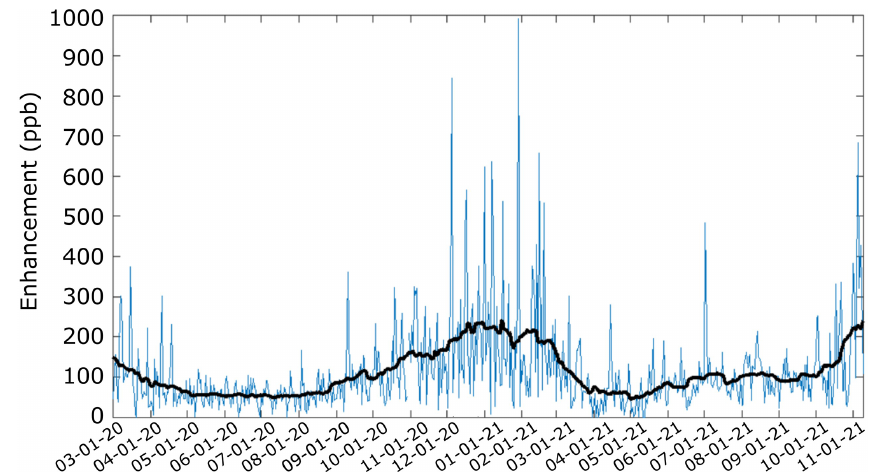
Figure 8. Daily afternoon differences (blue line) between the largest and smallest CH 4 mole fraction measured from the tower network from 1 March 2020 through 9 November 2021. Afternoon values are calculated by averaging measurements between 20:00–23:00 UTC. The black line indicates the 30d running mean.